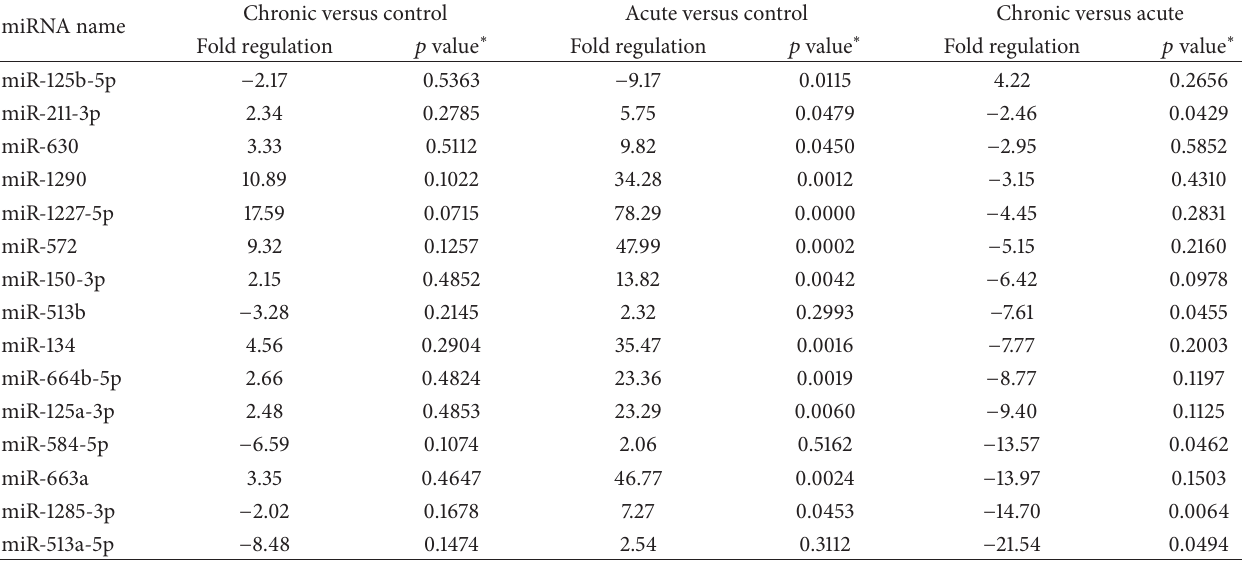
Table 2: List of miRNAs that were differently regulated between chronic and acute brucellosis.